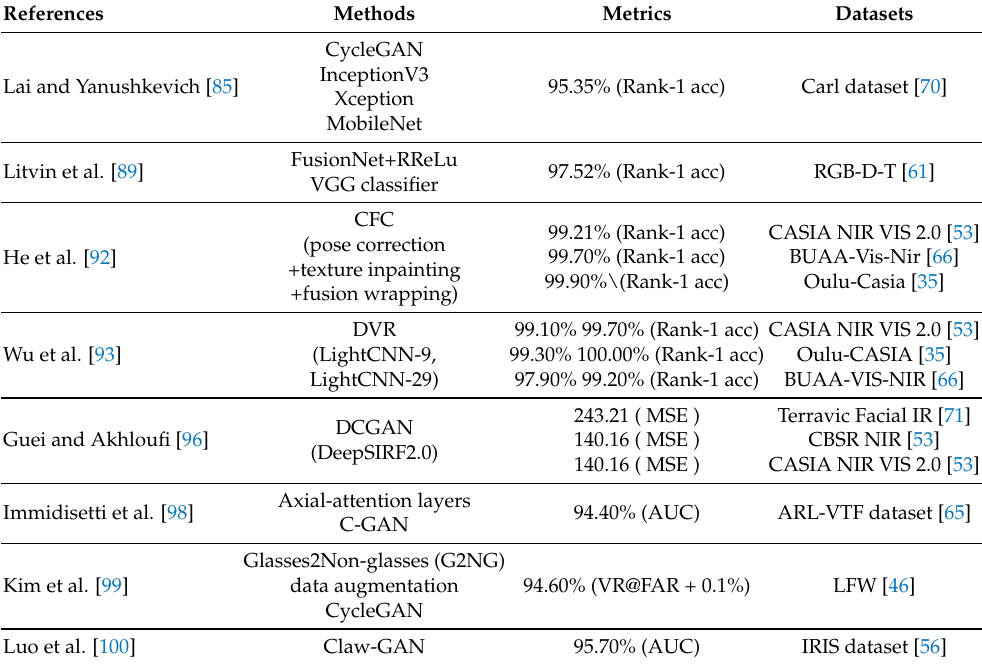
Table 2. Comparison of synthesis approaches